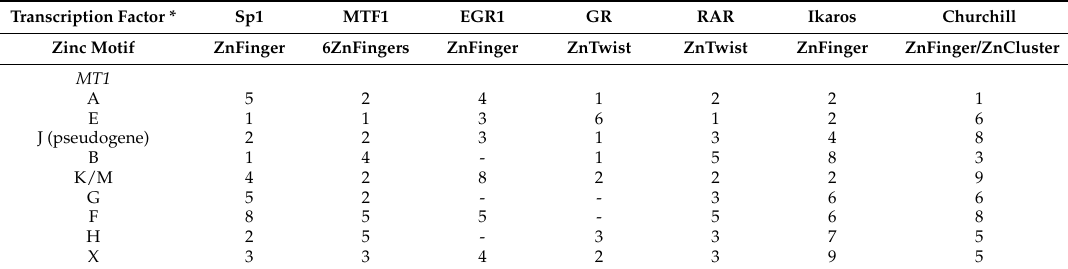
Table 3. Zinc-dependent transcription factors for human MT1 genes. The numbers designate cis acting elements in the promoters of the different MT1 genes